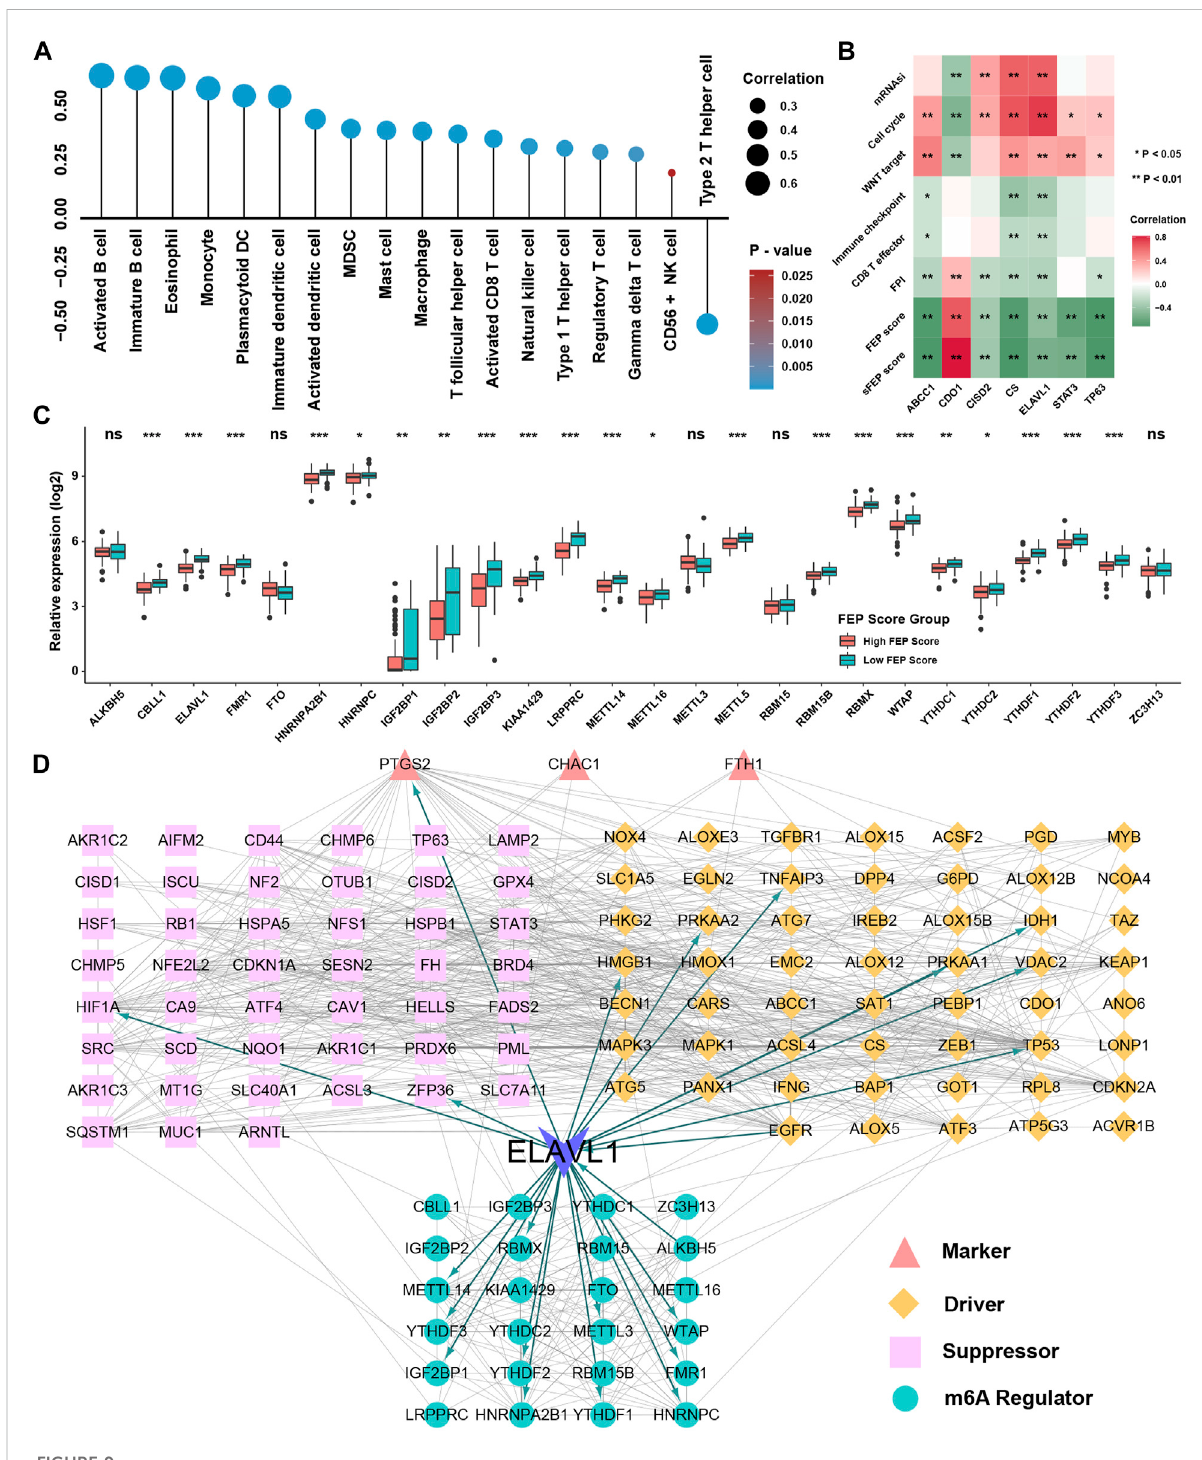
FIGURE 9 Construction of network among m6A regulators and ferroptosis regulators. (A) Correlation analysis between sFEP score and the immune cells in fi ltration levels. (B) Correlation analysis between seven ferroptosis genes and mRNAsi, FPI, FEP score and pathways. (C) The relative expression of m6A regulators in different FEP score groups. (D) Protein-protein interaction network among m6A regulators and ferroptosis regulators. The asterisks represented p values (* p < 0.05; ** p < 0.01; *** p < 0.001) and ns represented no signi fi